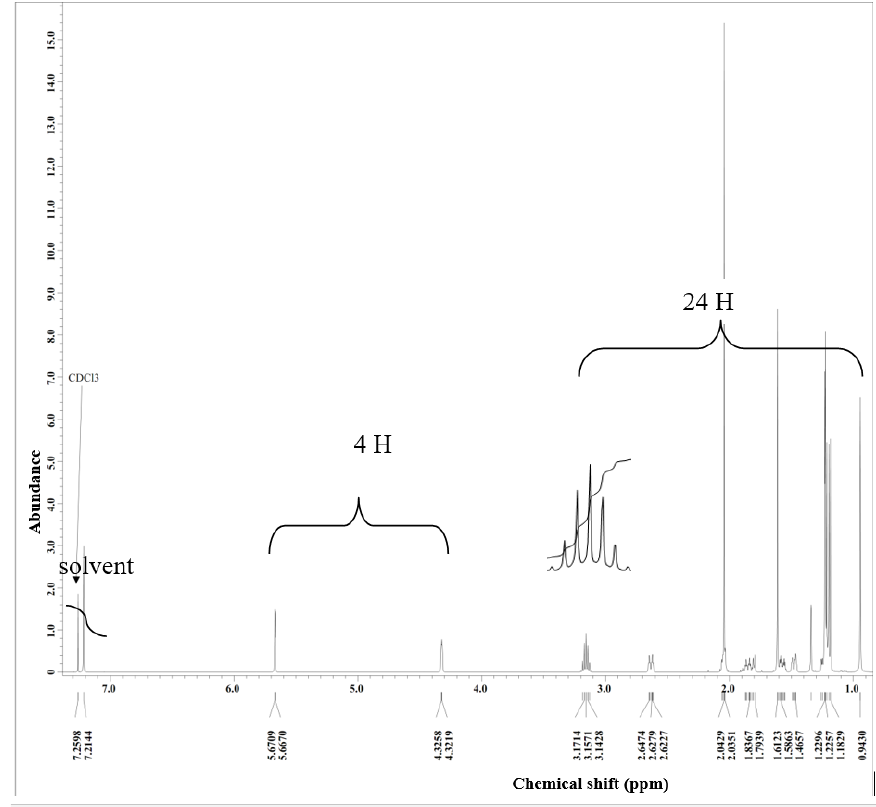
Fig. 3. Proton shift ( 1 H-NMR)